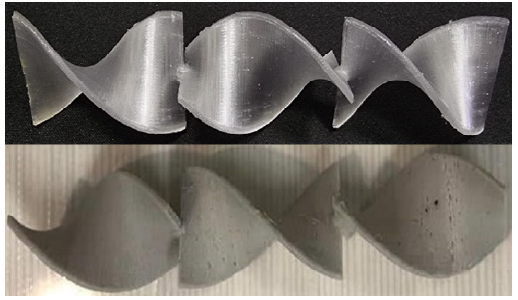
Figure 17. Three-dimensional-printed static mixers made of pure PET-G ( top ) and PET-G 6T 0.25C composite ( bottom ).